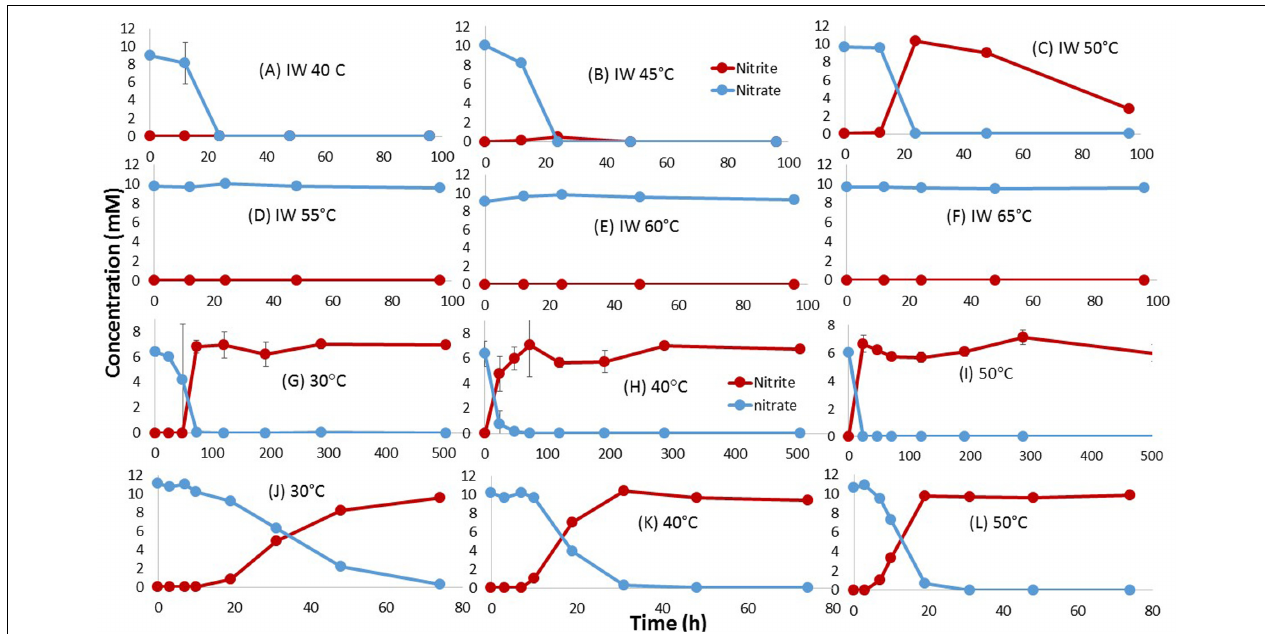
FIGURE 3 | Effect of incubation temperature on nitrate reduction in cultures derived from IW5\_15. Data are for primary enrichments (A–F) , for secondary enrichments inoculated with primary enrichment (C) grown at 50 ◦ C (G–I) and for a pure culture isolate, identified as Marinobacter sp., obtained at 50 ◦ C (J–L) . No growth was observed for the cultures in (G–L) at 55 ◦ C or higher temperature. The CSBA medium contained 3 mM VFA and 10 mM nitrate.